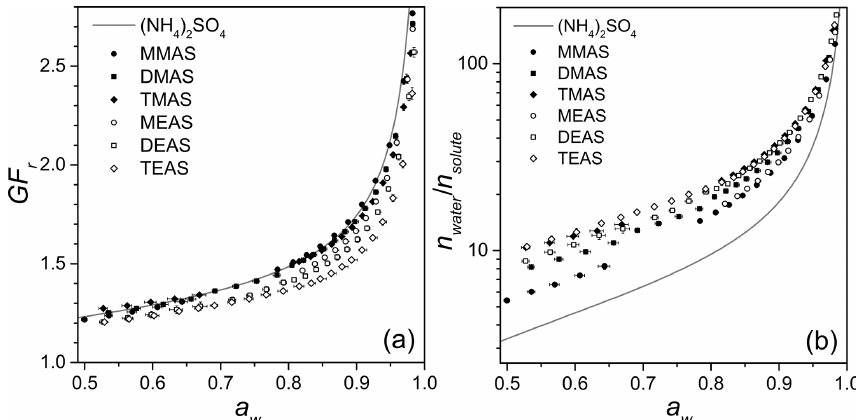
Figure 3. Aminium sulfate GF r vs. a w (a) and n water /n solute vs. a w (b) hygroscopic growth plots from CK-EDB experiments. Symbols: • – MMAS; (cid:4) – DMAS; (cid:7) – TMAS; (cid:13) – MEAS; (cid:3) – DEAS; ♦ – TEAS; line – E-AIM model calculation for (NH only E-AIM predictions for (NH 4 ) 2 SO 4 are reported in this and subsequent figures with the CK-EDB measurements and the E-AIM model compared in Fig. 2.